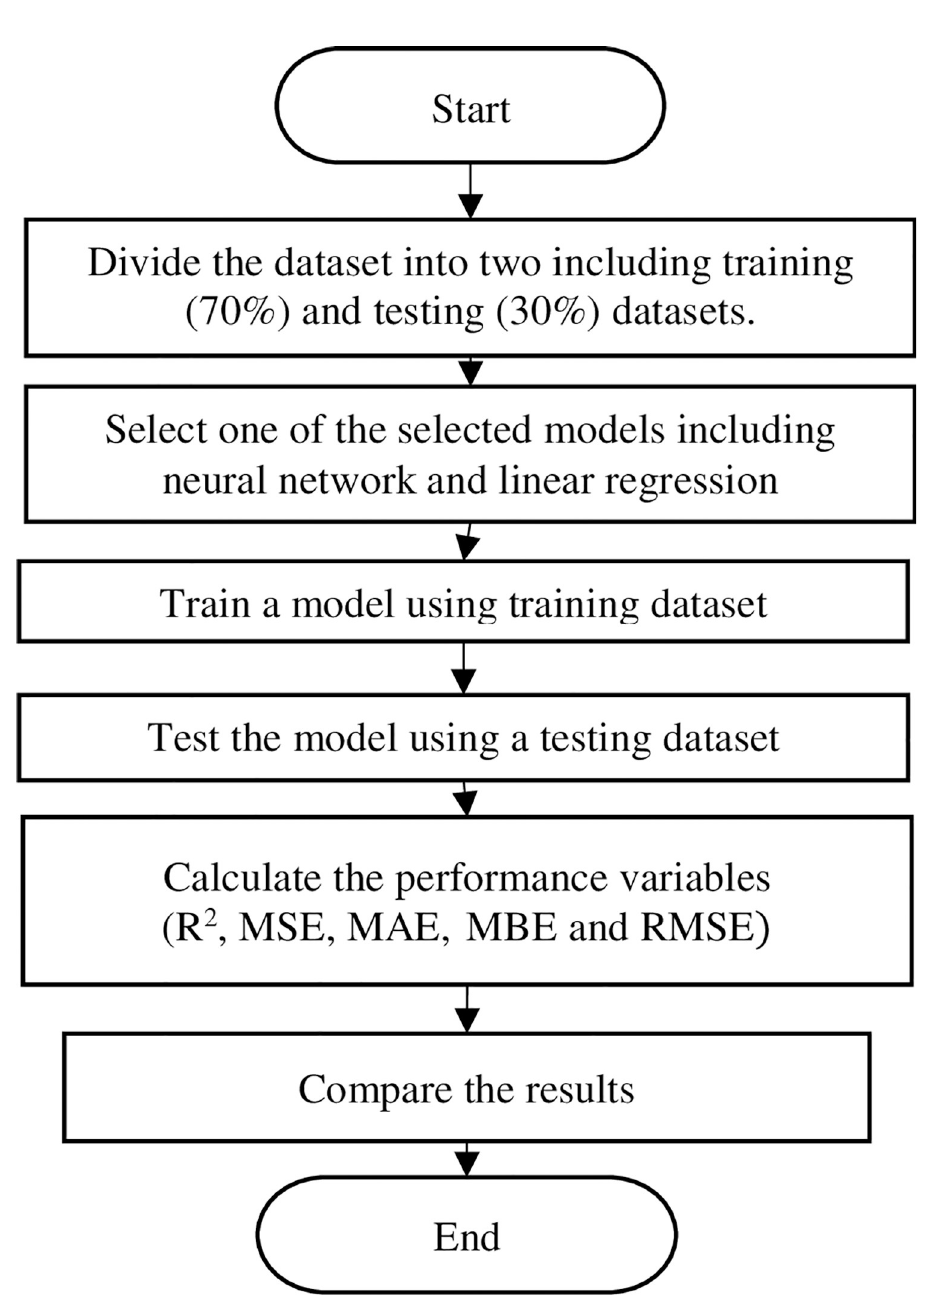
Fig 1. Flowchart of neural network and linear regression prediction